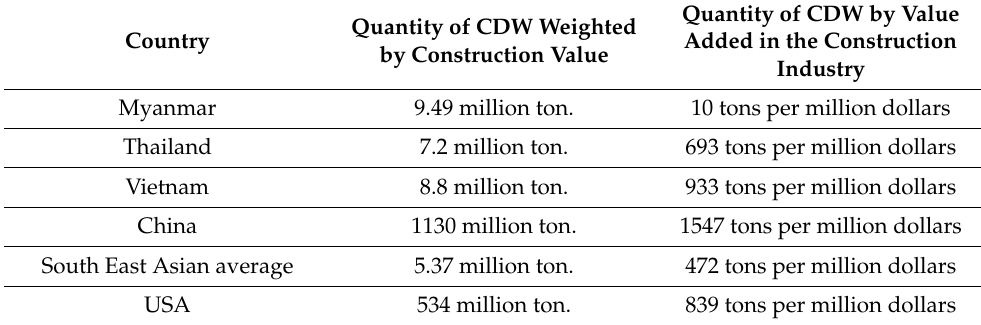
Table 1. Ways of quantifying CDW in some countries and regions [15–17].